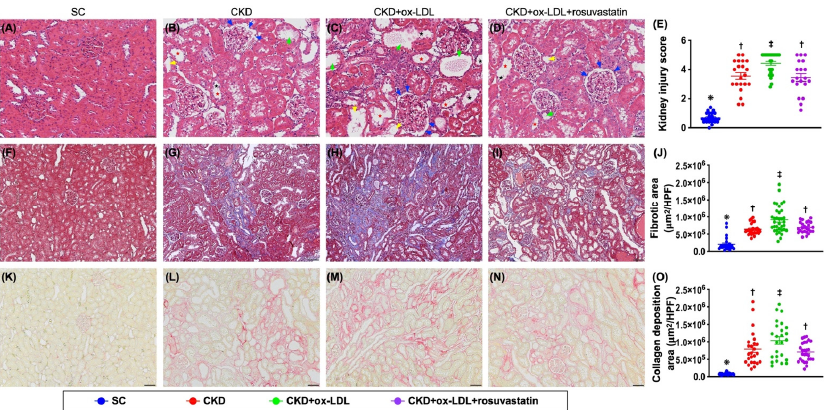
Figure 9. The histopathological analyses of kidney injury score and fibrosis in kidney parenchyma by day 42 after CKD induction. ( A – D ) Light microscopic findings (200 × ; H&E stain) showing significantly increased in loss of brush border in renal tubules (yellow arrows), tubular necrosis (green arrows), tubular dilatation (red asterisk), protein cast formation (black asterisk), and di- latation of Bowman’s capsule (blue arrows) in CKD + oxidized LDL group than in other groups. ( E ) Analytical result of kidney injury score, * vs. other group with different symbols (†, ‡), p < 0.0001. ( F – I ) Illustrating the microscopic finding (200 × ) of Masson’s stain for identification of fibrosis (blue color). ( J ) Analytical result of fibrotic area, * vs. other group with different symbols (†, ‡), p < 0.0001. ( K – N ) Illustrating the histological finding (200 × ) of Sirius red stain for identification of condensed collagen-deposition area in renal parenchyma (pink color). ( O ) Analytical result of condensed collagen-deposition area, * vs. other group with different symbols (†, ‡), p < 0.0001. Scale bars in right lower corner represent 50 µ m. All statistical analyses were performed by one-way ANOVA, followed by Bonferroni multiple comparison post hoc test (n = 6 for each group). Symbols (*, †, ‡) indicate significance for each other (at 0.05 level).